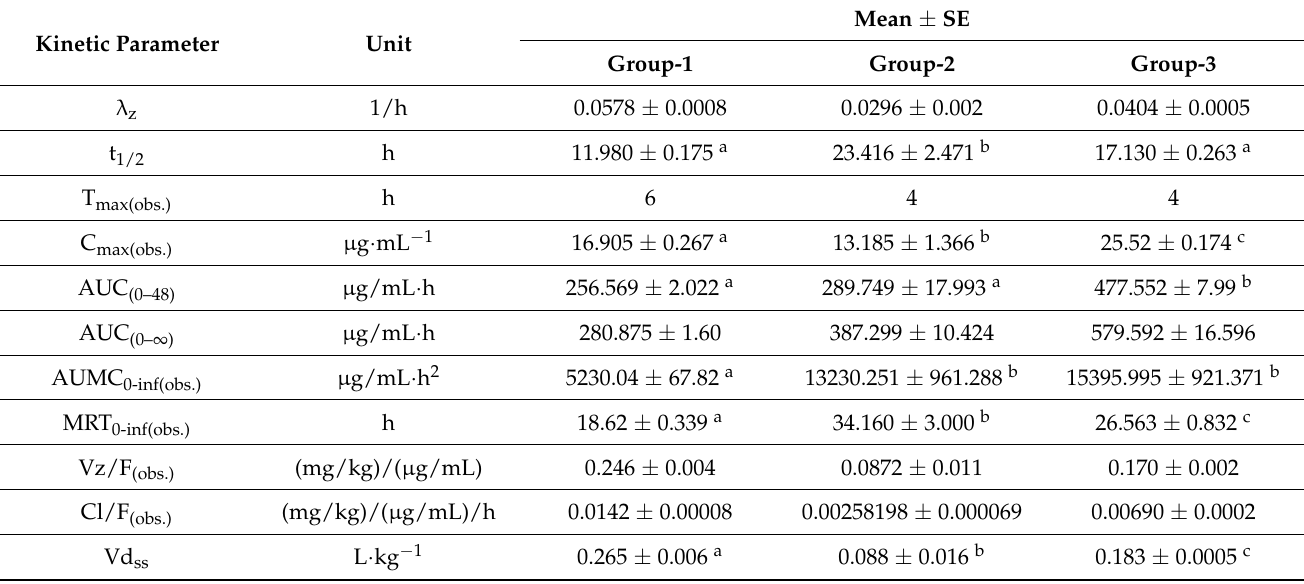
Table 2. Pharmacokinetic variables of following single oral administration of meloxicam (4 mg · kg − 1 ) and high (4 mg · kg − 1 ) or low (1 mg · kg − 1 ) dose of chitosan-encapsulated meloxicam nanoparticles (CEMNPs) in male Wistar rats (n = 3 at each time